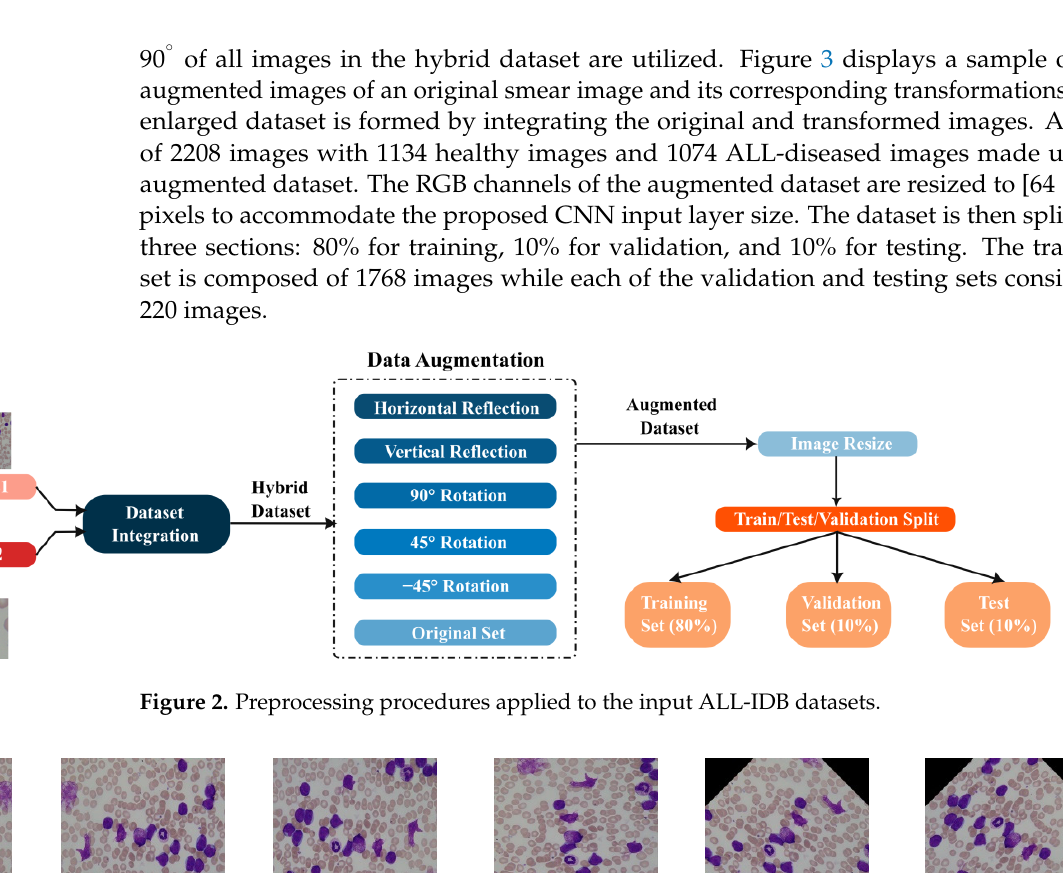
Figure 2. Preprocessing procedures applied to the input ALL-IDB datasets.